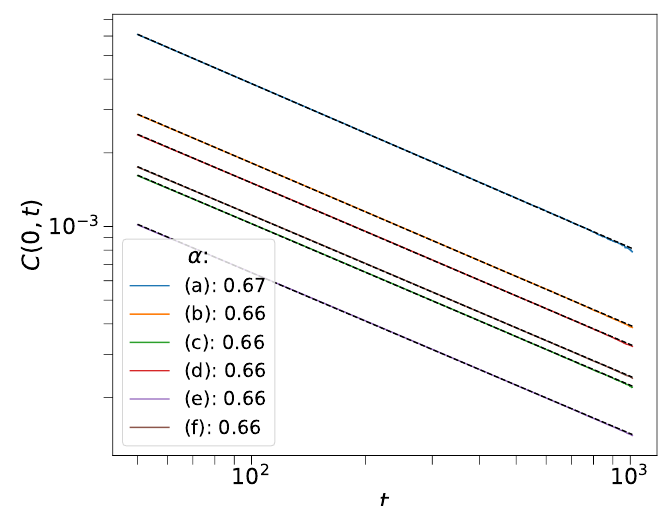
Figure 6: Algebraic dynamical exponents α = 1 / z characterizing the asymptotic de- ( 0, t ) ∼ | t | − α (for the corresponding datasets shown in Fig. 5) cay of correlators C q obtained by least square